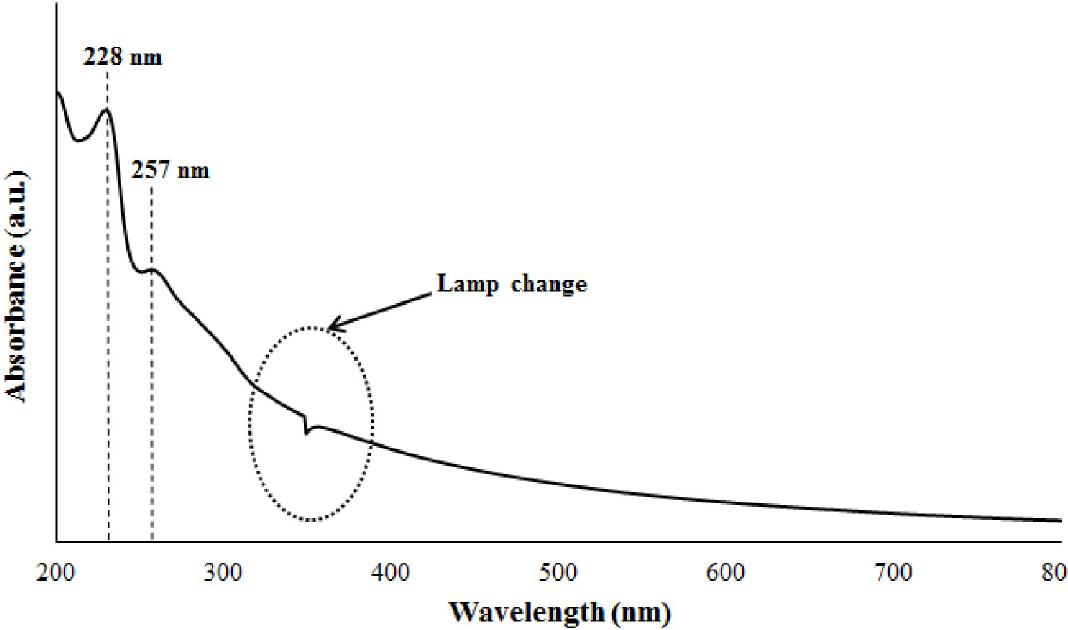
Fig 7. UV-Vis spectrum for crude O/W emulsion (264 mg L -1